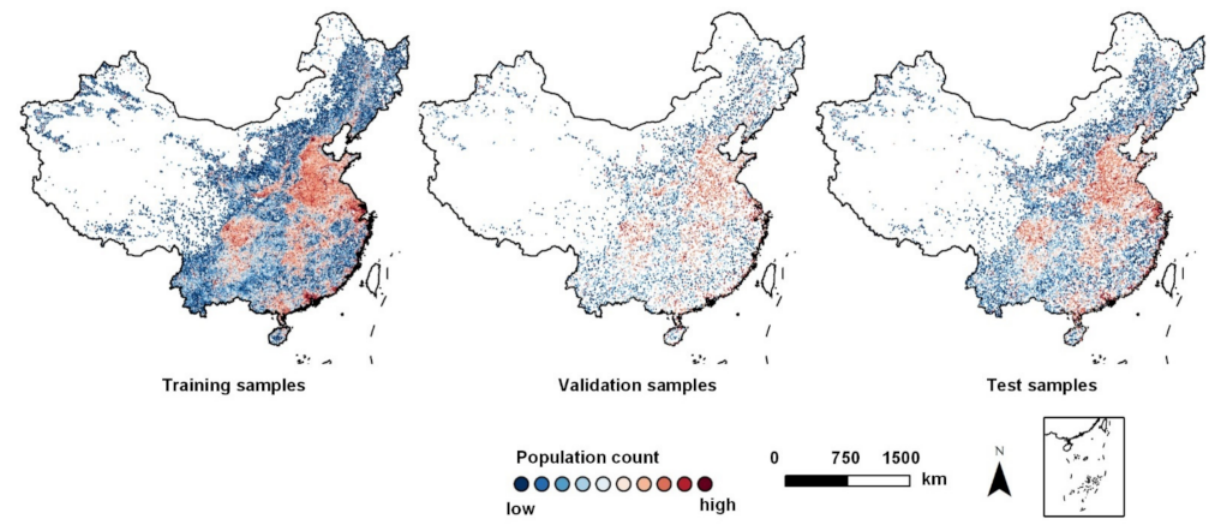
Figure 3. The spatial distribution of the ground-truth population